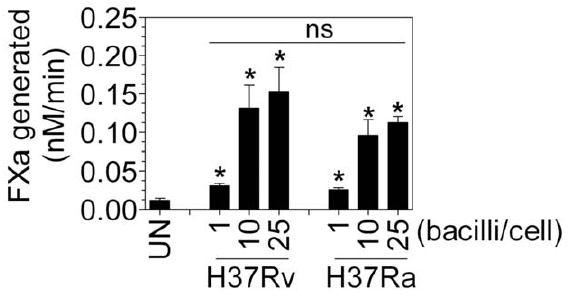
Figure 9. Both H37Ra and H37Rv induce TF on macrophages. MDMs in complete medium without antibiotic were infected with live H37Rv and H37Ra at varying ratios of bacteria:cell. After 2 h, the cells were washed twice with warm RPMI serum free medium and then incubated overnight in fresh complete medium. At the end of incubation, TF activity at the cell surface was measured in factor X activation assay. ns, not statistically significant. Data are mean 6 SEM (